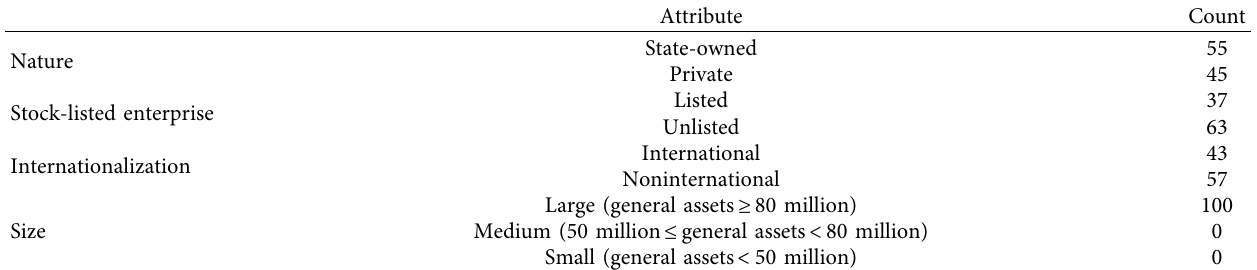
Table 2: Descriptive statistics of the 100 enterprises.